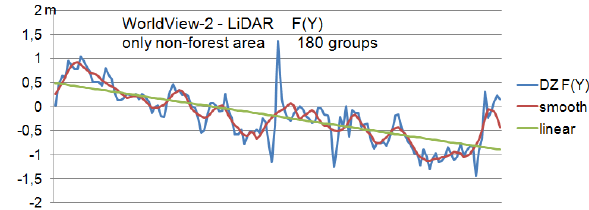
Figure 19. Systematic discrepancies of WorldView-2 DSM, bias corrected by affine transformation, computed for 180 discrepancies in non-forest areas, mask open5